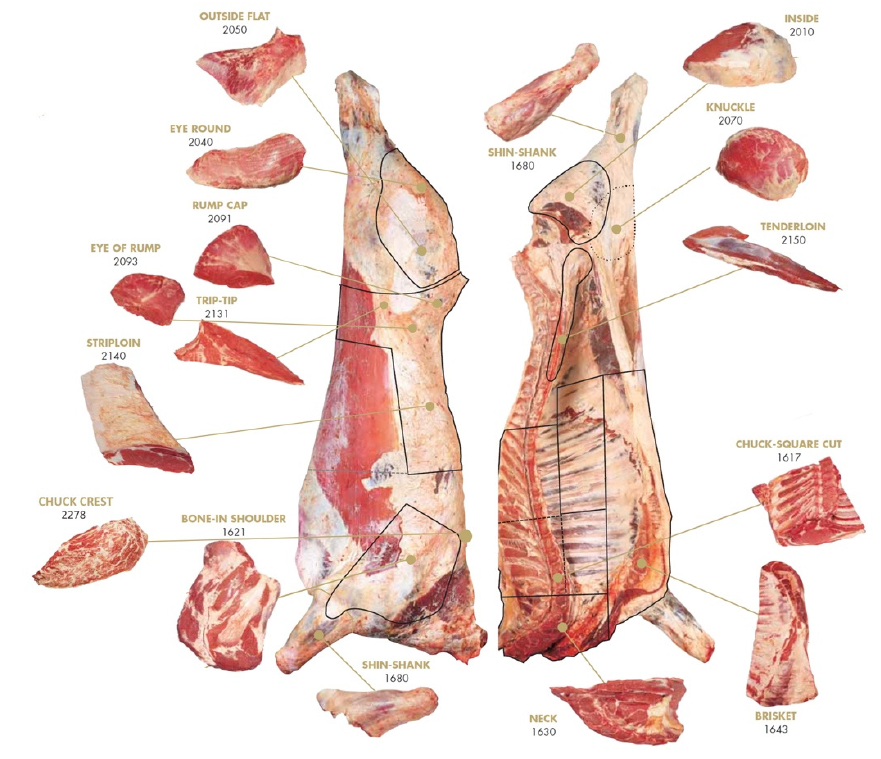
Figure 1. Forequarter and hindquarter boneless cuts evaluated to determine the saleable meat yield (Adapted from UNECE Standards-Bovine Meat Carcasses and Cuts